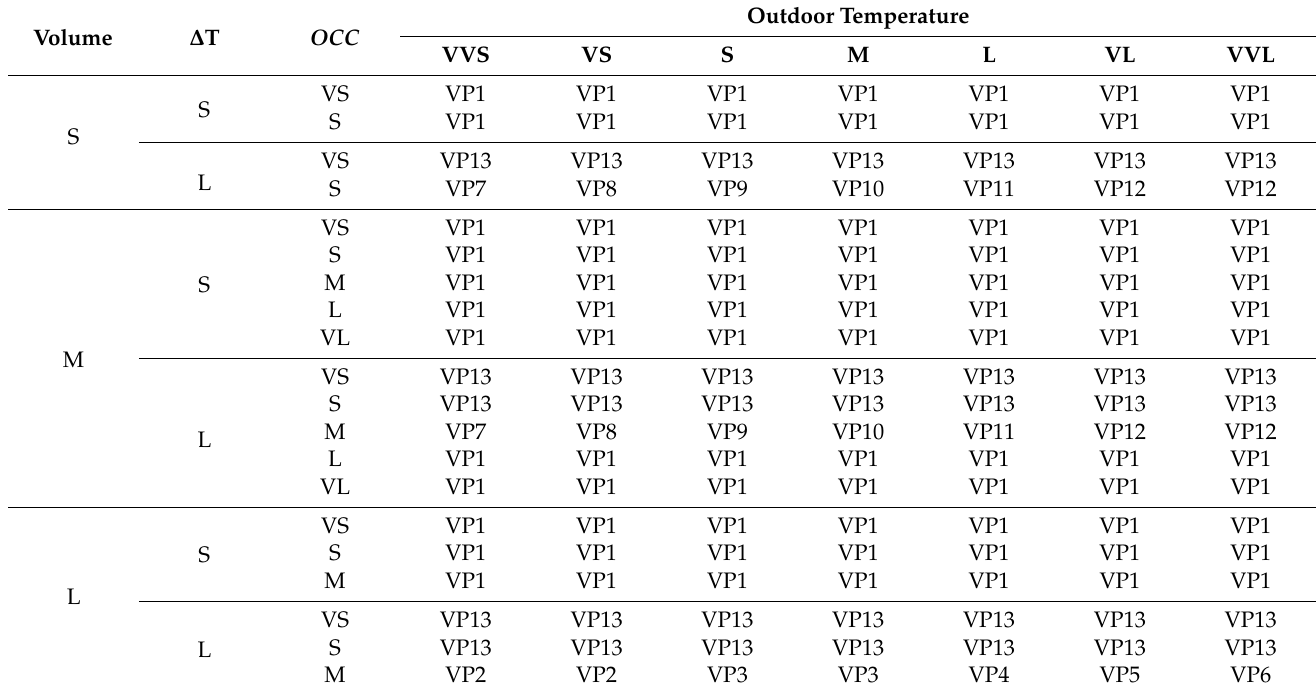
Table 2. Fuzzy rule of the adaptive controller. VVS: very very small, VS: very small, S: small, M: medium, L: large, VL: very large, VVL: very very large OCC : occupation, VP: valve position.